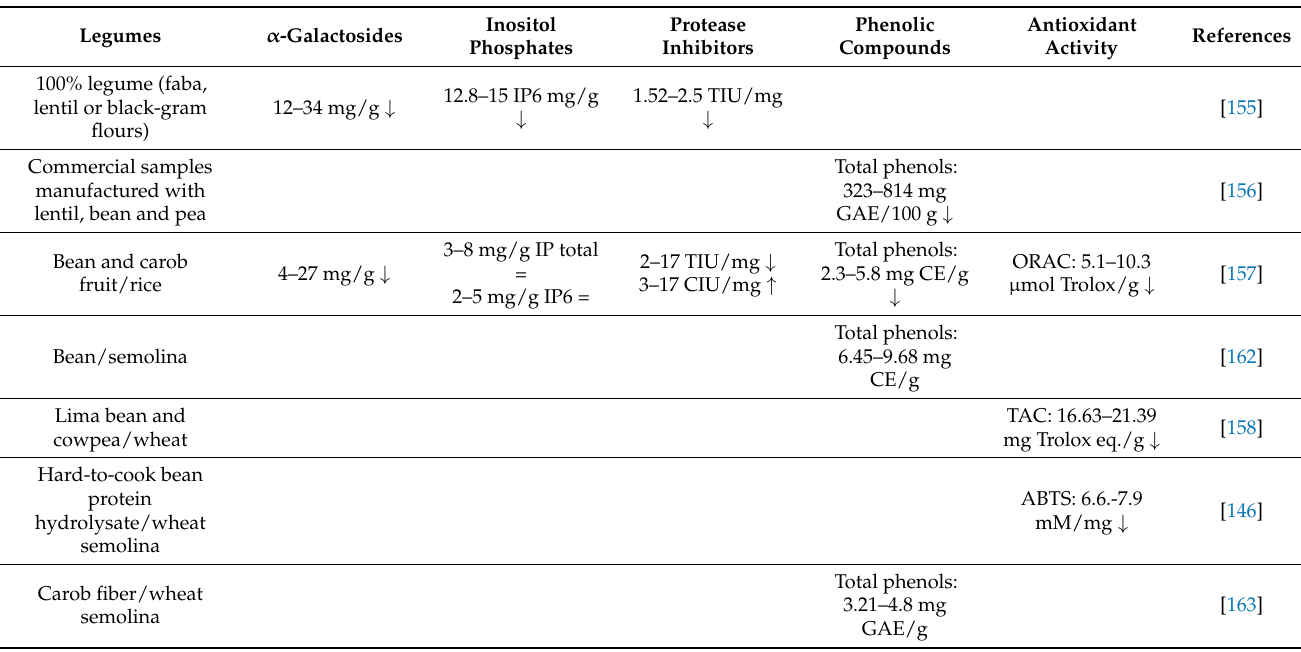
Table 5. Content of different bioactive compounds ( α -galactosides, inositol phosphates, protease inhibitors, phenolic compounds and antioxidant activity) in cooked legume-based